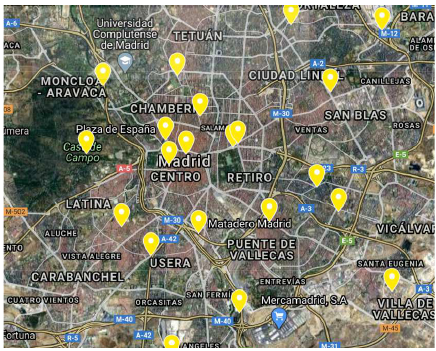
Figure 3. Weather stations in